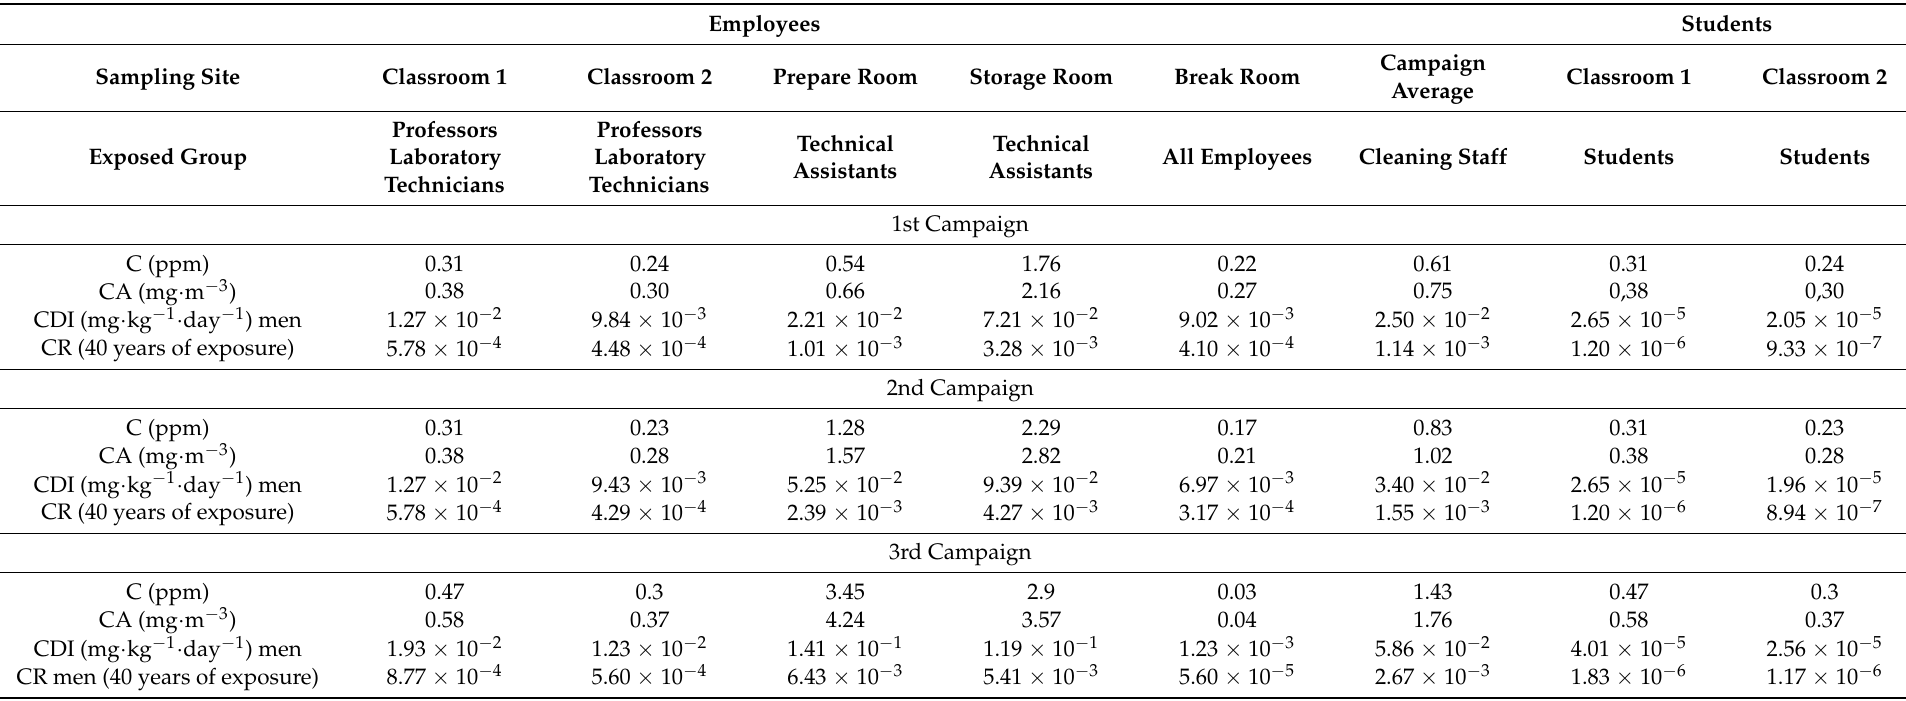
Table 3. Exposure to formaldehyde (CDI) and cancer risk (CR) of employees and students at the examined